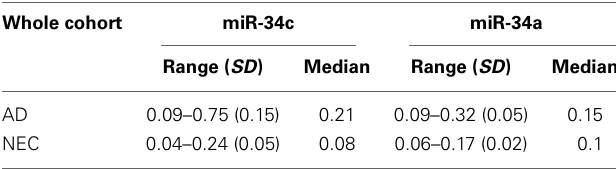
FIGURE 3 | Transcript levels of miR-34a and miR-34c in plasma samples of age-matched cohorts of Alzheimer’s disease (AD) patients and normal elderly controls (NEC). (A) Plasma level comparison of miR-34c in the age-matched cohort of AD patients ( n = 25) with the NEC cohort ( n = 27). AD plasma samples in the age-matched cohort showed higher miR-34c levels than controls. (B) Distribution of individuals’ levels of miR-34c along the box plot; NEC individuals were distributed in a close cluster around the median of the box plots, while AD patients were distributed over a wider range with greater standard deviation. (C) Comparison of plasma levels of miR-34a in age-matched cohorts of AD patients ( n = 25) with the NEC cohort ( n = 27). miR-34a levels were distributed in a range that is not differentially expressed between AD and NEC groups, with more spread-out distribution for both groups, as well as significant overlapping ranges, by both box and scatter plots. Distributing individuals along the box plot, NEC were distributed in a close cluster around the median levels of the box plots, whereas AD specimens were distributed over a wider range with higher standard deviation. Data points represent Mini-Mental Status Examination (MMSE) score as follows, ( ) severe AD (4–9), ( ) moderate AD (10–20), ( ) mild AD (21–24), and ( ) NEC (25–30). (D) Representation of individual miR-34a levels along the box plot for the range of distribution between AD and NEC groups. The data are plotted as inverse (cid:2) Ct derived from qPCR analysis. Student’s t- test was used to determine statistical significance; ∗∗ P < 0 . 01.